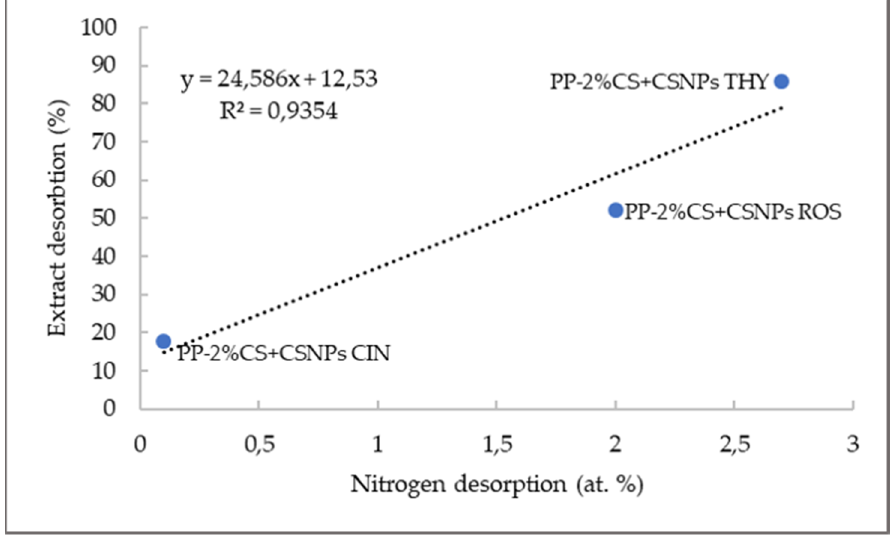
Figure 4. Correlation between nitrogen desorption and extract release.